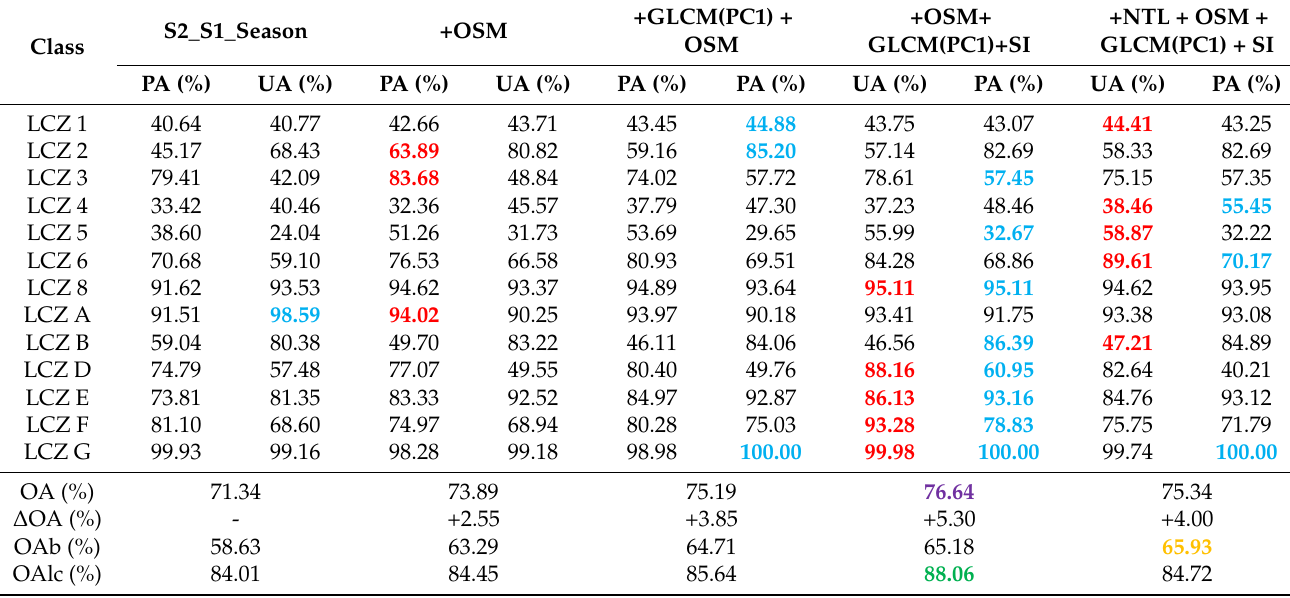
Table 9. The accuracy comparison of the basic combination “S2_S1_season”, the combinations adding a different number of secondary datasets with the highest OA value and combining all secondary